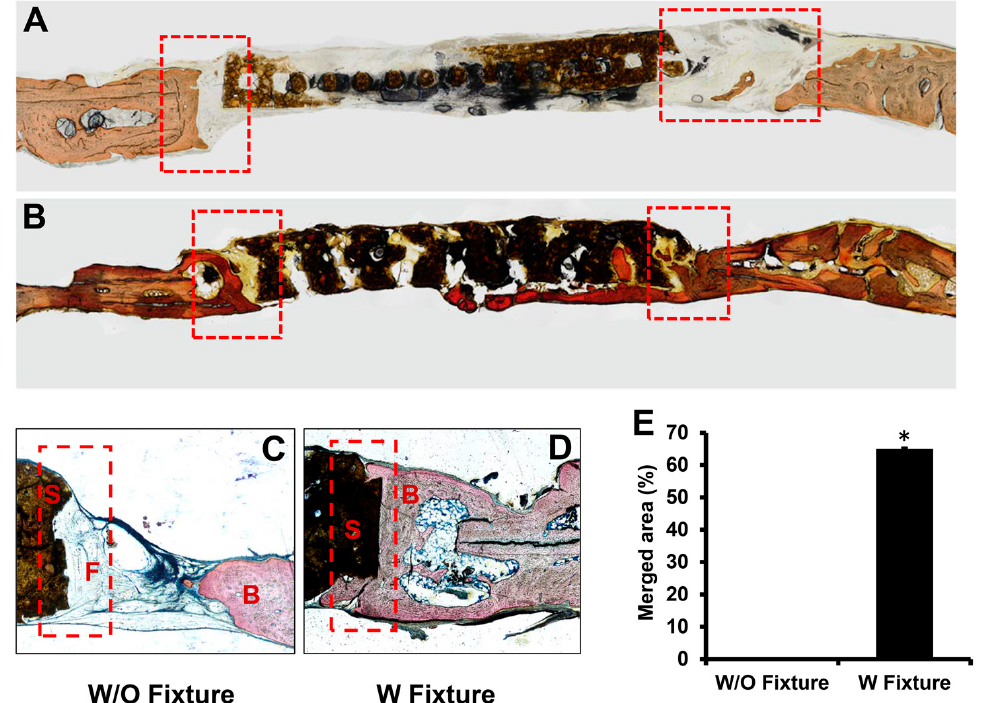
Figure 4. Histological section of the area between host bone and scaffold after 12 weeks of implantation without ( A , C ) and with ( B , D ) fixture. Sections were stained with Stevenel’s Blue and Van Gieson’s stain after grinding process. Dotted rectangles represented region of interest (ROI). S: scaffold F: fibrous tissue and B: bone. The merged area between host bone and scaffold was quantified in percentage using Image J software, ( n = 5, * p <0.05) ( E ).